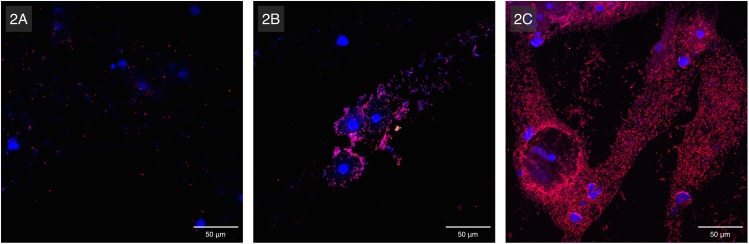
Superimposed confocal laser scanning microscopy images with 400x magnification of Gardnerella vaginalis biofilm, in three vaginal samples: vaginal epithelial cells DAPI in blue and G. vaginalis specific PNA-probe Gard162 with Alexa Fluor 647 in red.2A shows an example of dispersed-only G. vaginalis (negative for biofilm), 2B shows a light G. vaginalis biofilm (a small number of bacteria are adhering to the vaginal epithelial cells) and 2C is an example of a heavy G. vaginalis biofilm (the vaginal epithelial cells are covered by bacteria).